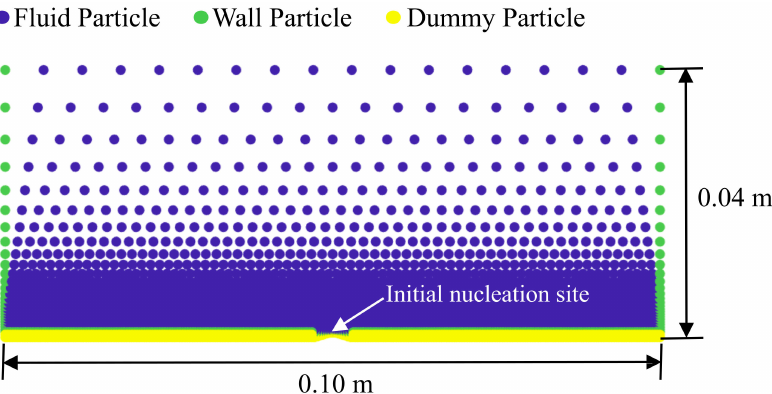
Figure 6. The initial particle arrangement of the pooling bubble growth